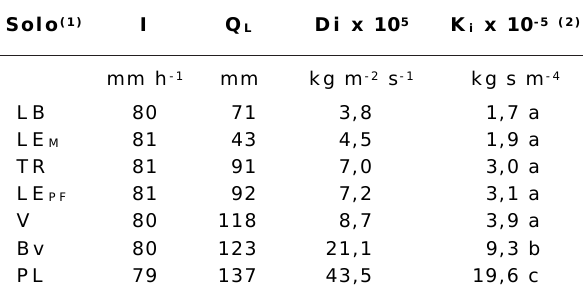
(1) LB = Latossolo Bruno Câmbico; LE Escuro de Marau; TR = Terra Roxa Estruturada; LE Vermelho-Escuro de Passo Fundo; V = Vertissolo; Bv = Brunizém Vértico; PL = Planossolo. (2) Médias seguidas pela mesma letra não diferem significativamente P < 0,01 (DMS).